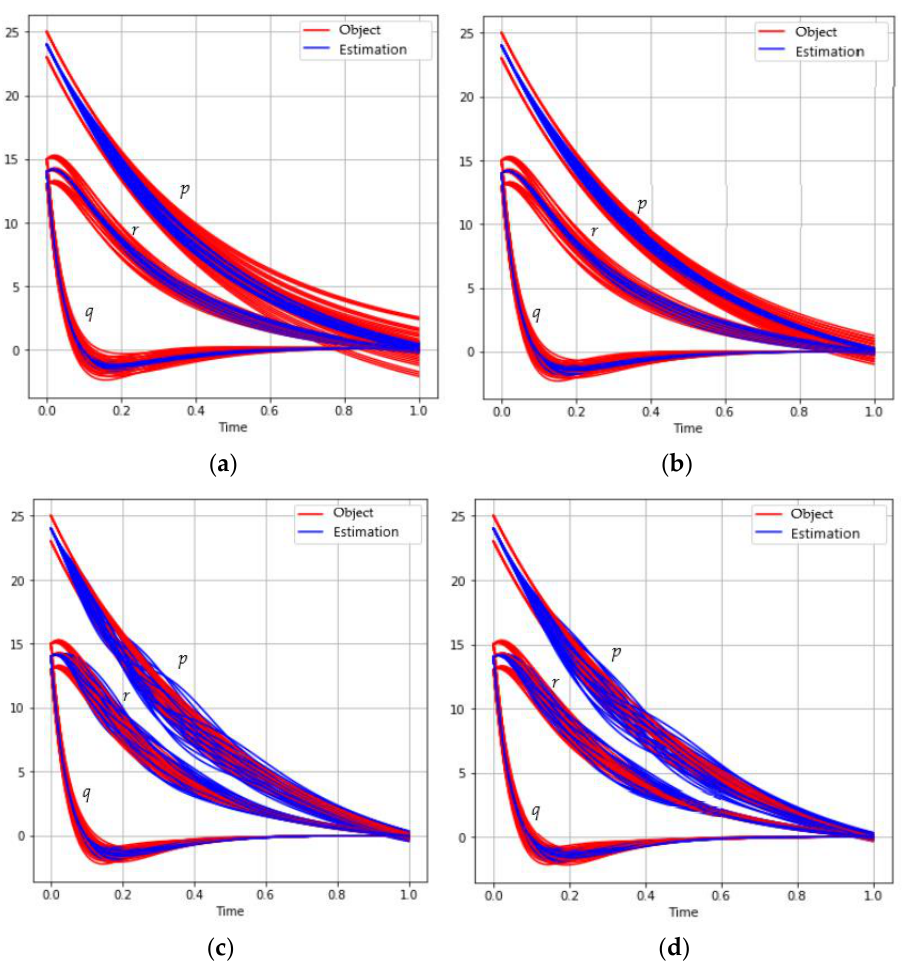
Figure 3. The behavior of the satellite coordinates p , q , r (red) and estimations (blue) for different mini-batch sizes: ( a ) d = 1; ( b ) d = 10; ( c ) d = 20; ( d ) d =